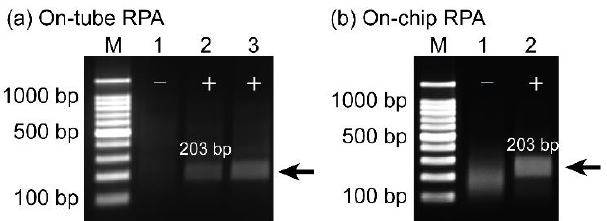
Figure 6. ( a ) On-tube RPA results of a 203 bp target gene using plasmid DNA of SARS-CoV-2. ( b ) On-chip RPA results of a 203 bp target gene from plasmid DNA of SARS-CoV-2. Lane M is the 100 bp DNA ladder. Lane 1 is a negative sample. Lanes 2 and 3 are the positive samples. All the experiments were repeated three times.